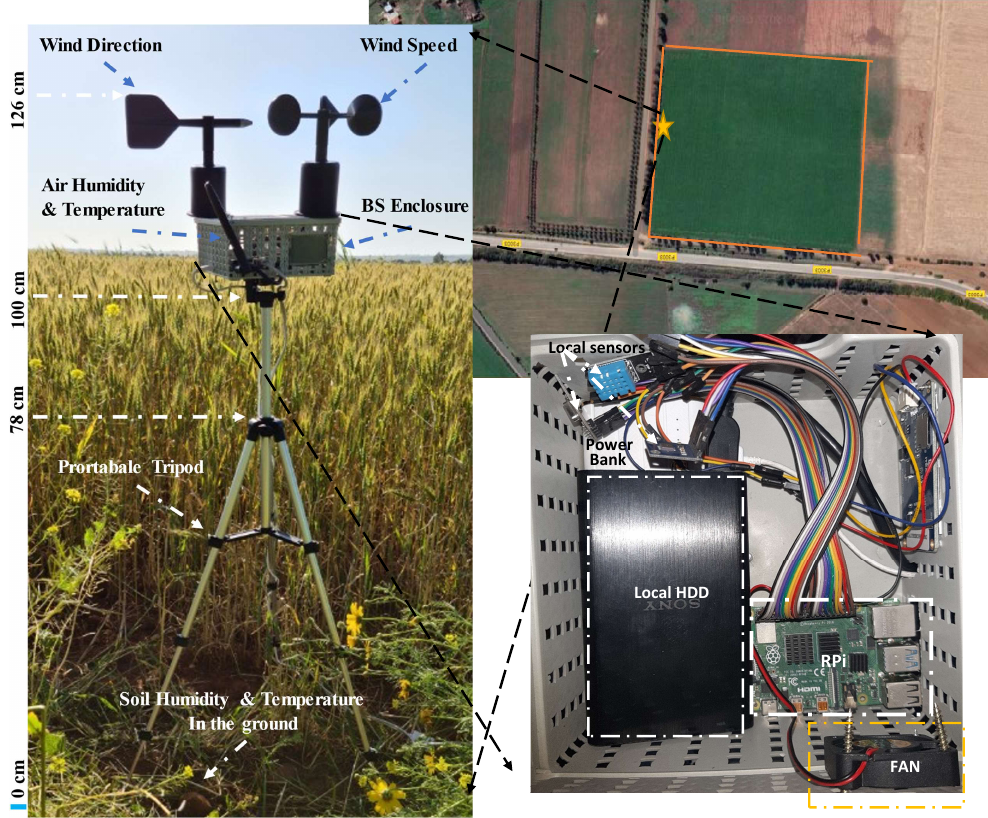
Figure 10. The agro-weather station in a field in Casablanca,